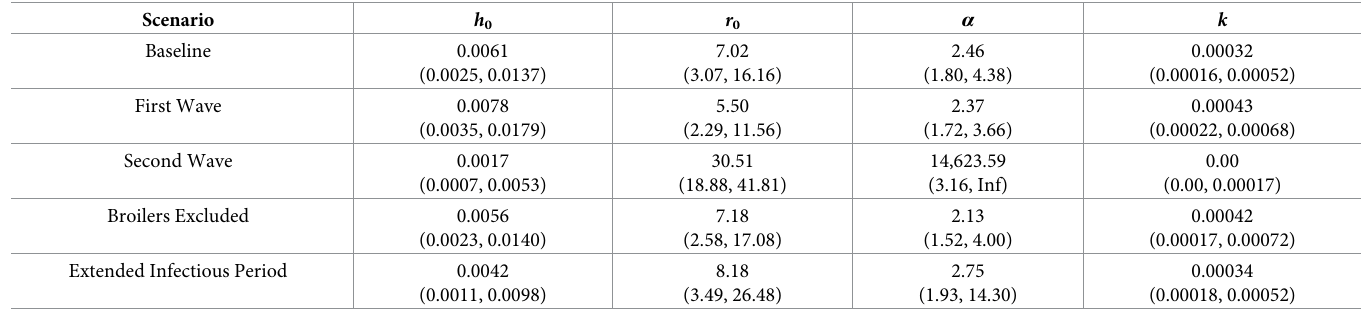
Table 1. Minnesota spatial transmission kernel maximum likelihood